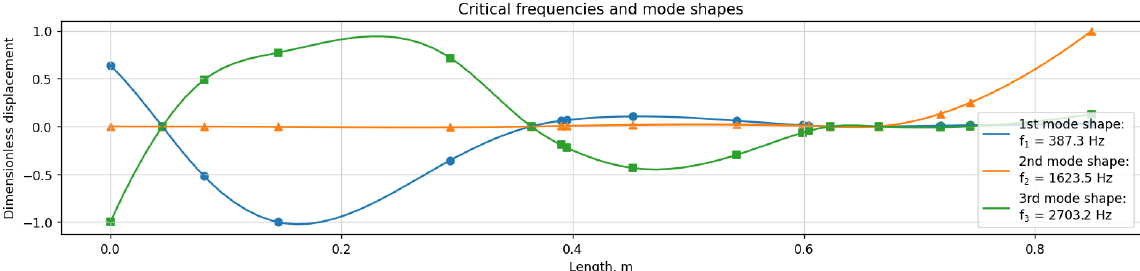
Figure 7. Eigenfrequencies and mode